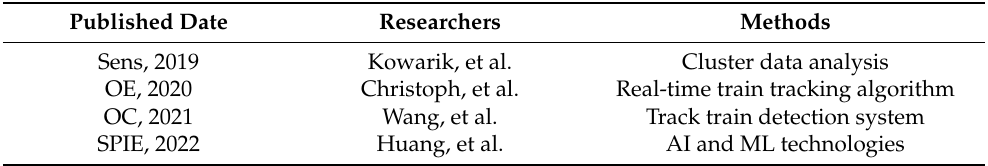
Table 11. Summary of railway monitoring applications.